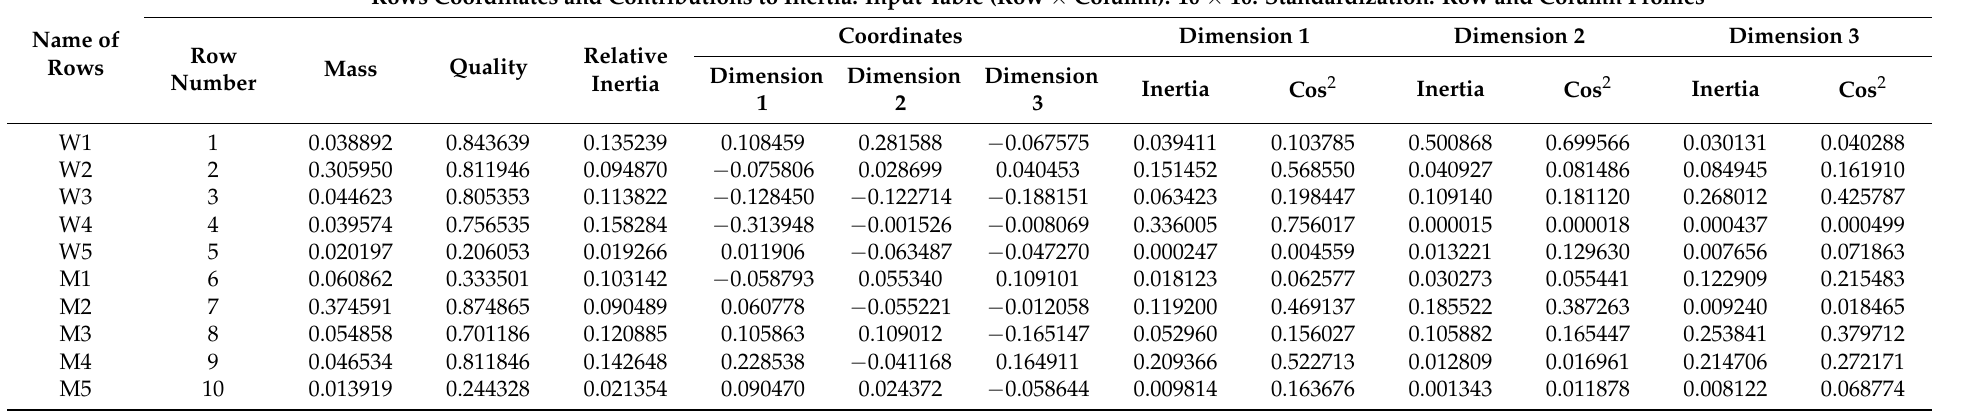
Table 4. Row coordinates and the statistics of the quality of the solution.